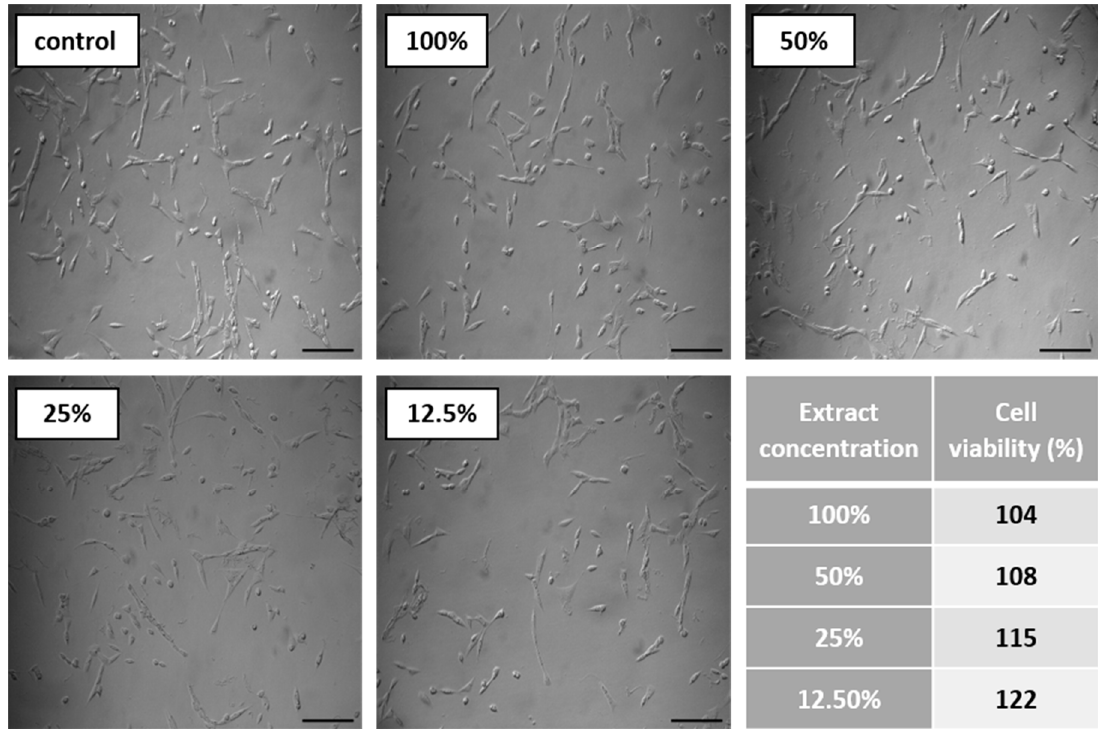
Figure 8. Results of cytotoxicity test. Images show CCL-163 cells morphology after 24 h contact with TPU_P extracts of specified concentrations (100–12.5%). Scale bar = 50 µm. The table present percentage of cell viability towards control (100%). SD were negligibly small, there were no statistical differences between the obtained results.